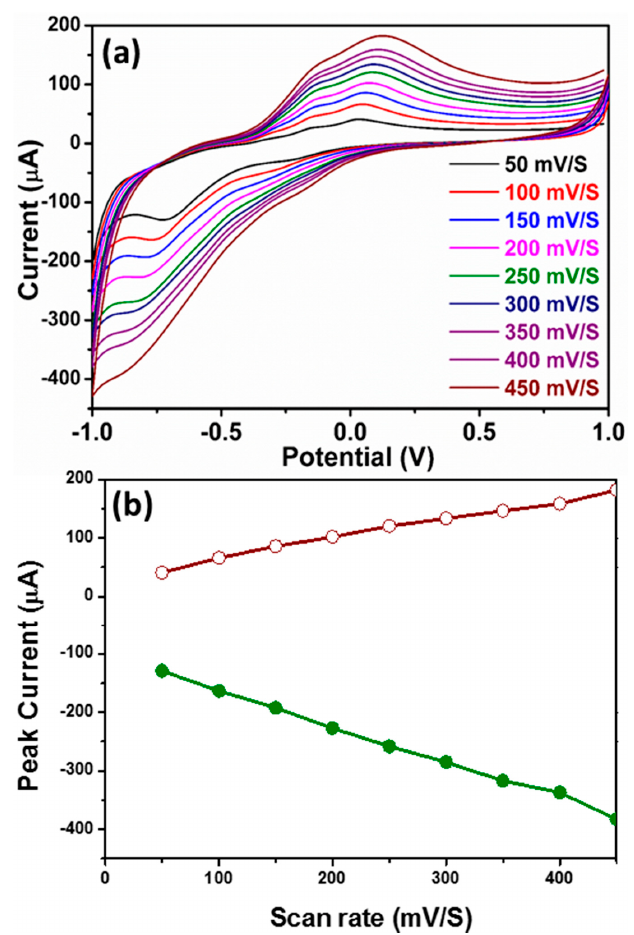
Figure 6. Typical ( a ) CV response curves at different scan rates (50, 100, 150, 200, 250, 300, 350, 400, and 450 mV/S) for a ZnO nanopeanut-modified SPE in 0.1 M PBS (pH = 7.4) containing 2 mM picric acid and ( b ) Variations of peak current with scan rate.